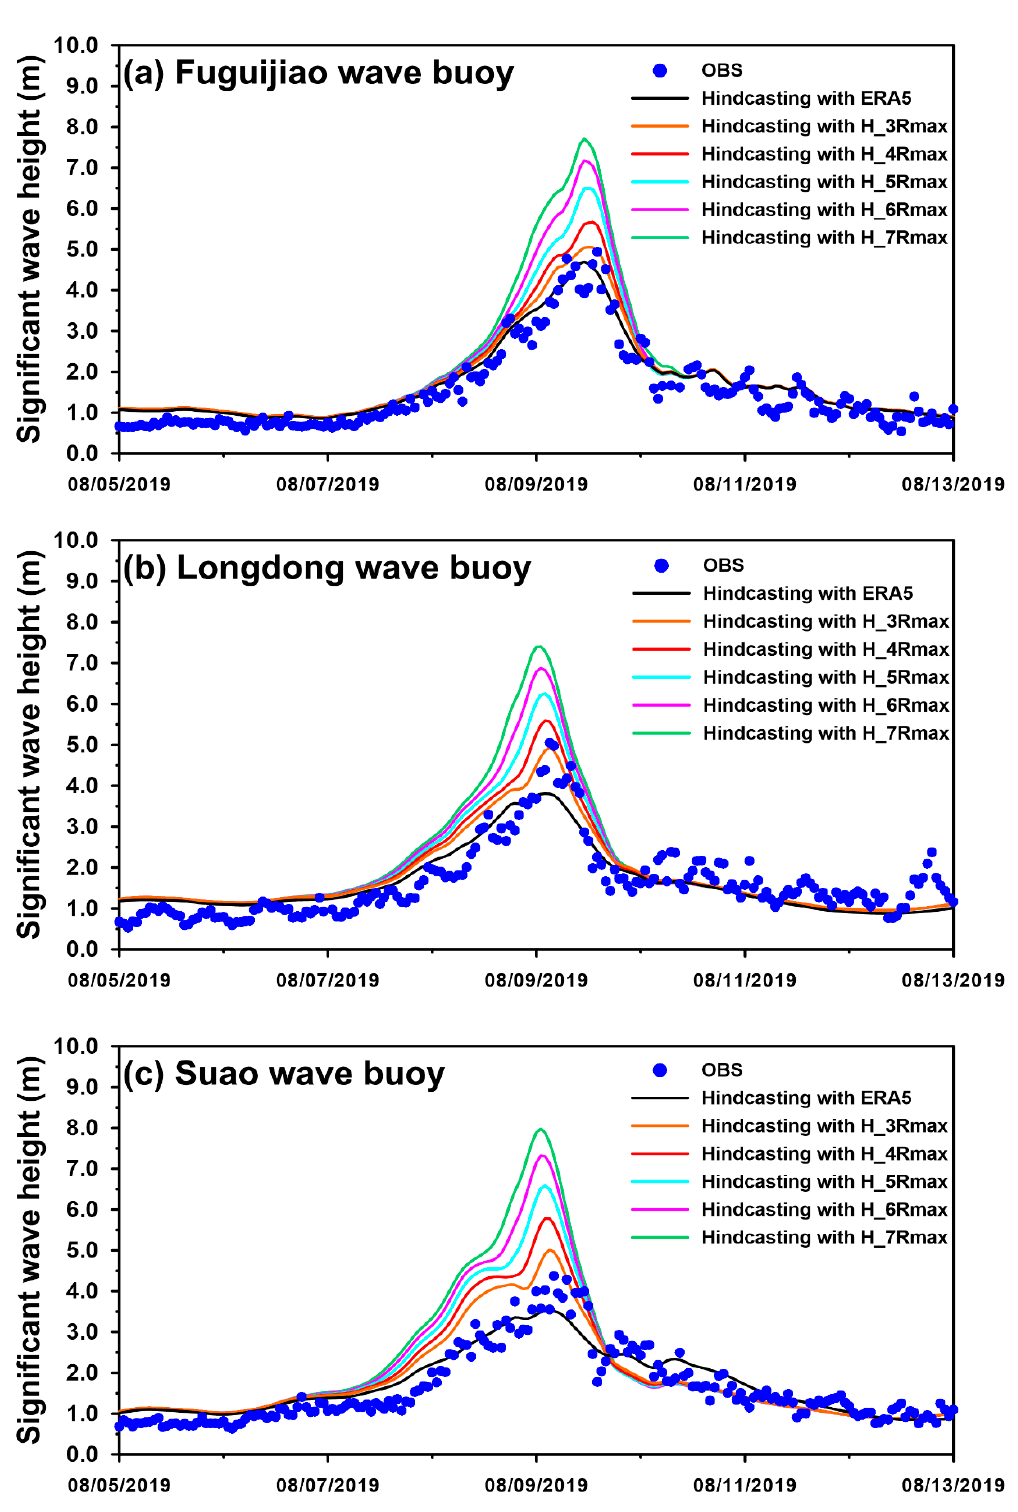
Figure 6. Comparison of the time series of the SWH between the wave simulation that used the winds from the original ERA5, from the hybrid winds with various R trs , and the corresponding observations for the ( a ) Fuguijiao, ( b ) Longdong and ( c ) Suao wave buoys during the passage of Super Typhoon Lekima in 2019.